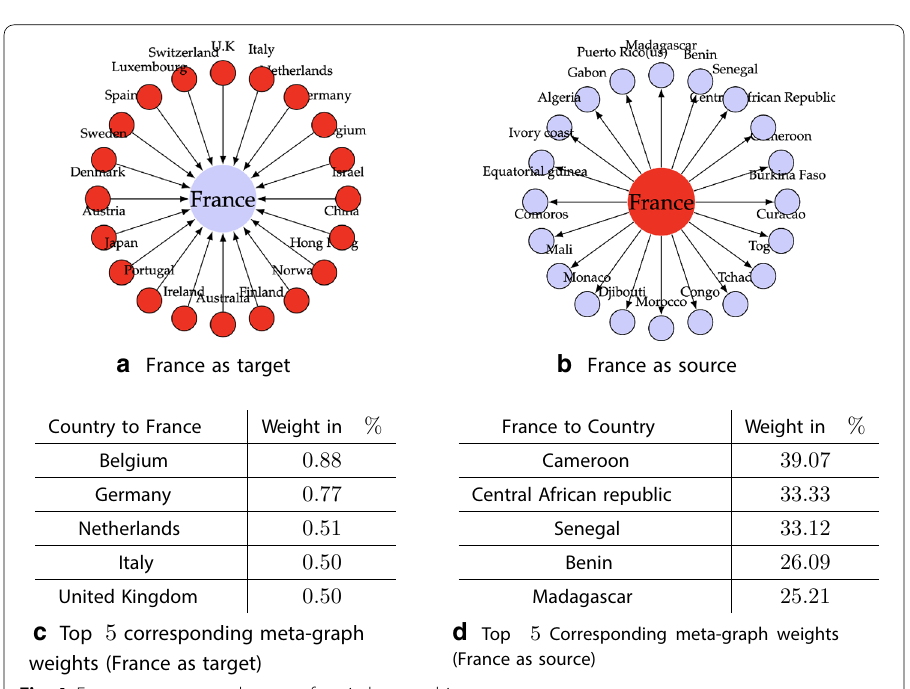
Fig. 4 France as source and target of capital